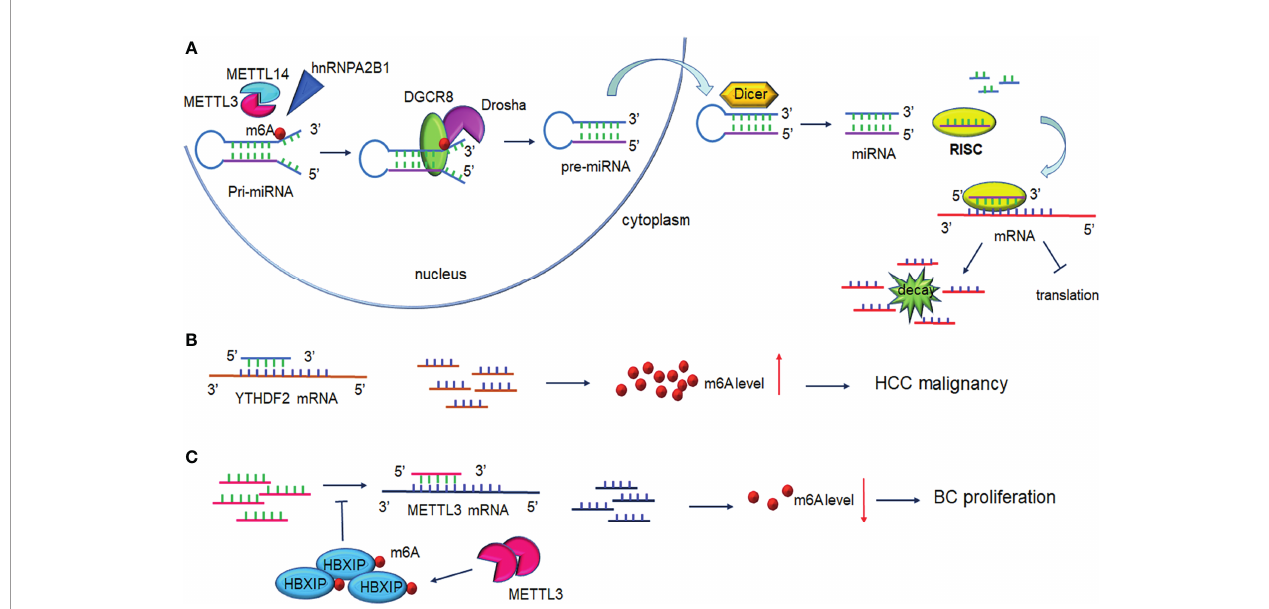
FIGURE 3 | Interplay between microRNA and m6A modi fi cation. (A) m6A modi fi cation promotes pri-miRNAs processing. METTL3/ETTL14 facilitates DGCR8 recognition of pri-miRNAs contributing to the increased levels of mature miRNAs under the cleavage of Drosha and Dicer. One strand of the miRNAs is loaded on RISC and mediates mRNA silencing or translation repression. (B) MiRNAs regulate m6A levels through binding to m6A readers. MiRNAs bind to YTHDF2 mRNA inducing its degradation and interfere with HCC cell malignancy. (C) MiRNAs regulate m6A levels by binding to m6A writers. miRNAs degrade METTL3 mRNA and lead to decreased breast cancer cell proliferation. Upregulation of METTL3 contributes to HBXIP m6A modi fi cation, in turn, HBXIP reverses the miRNAs-induced degradation of METTL3, forming the positive feedback of METTL3/HBXIP/miRNA/METTL3. DGCR8, DiGeorge syndrome critical region 8; RISC, RNA-induced silencing